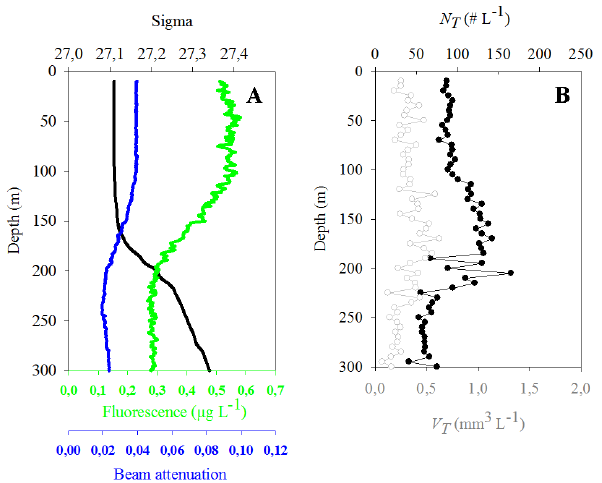
Figure 1. Vertical distribution of sigma (black line), fluorescence (green line), and turbidity (blue line) (A) and vertical profiles of total abundance ( N T ) and total volume ( V T ) at the first cast of A3, during winter (A3-1, 21 of October) (B) .